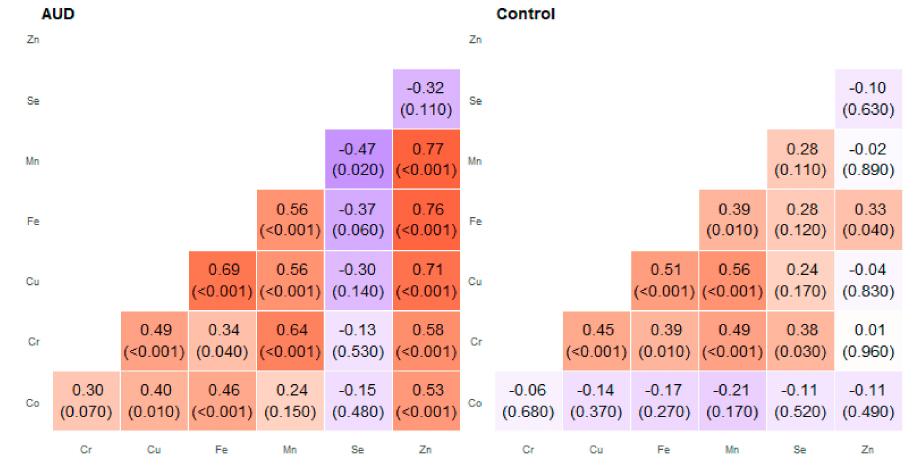
Figure 6. Correlation matrix of Spearman coe ffi cient charts in the inferior longitudinal fasciculus region in the alcohol use disorder and control groups.